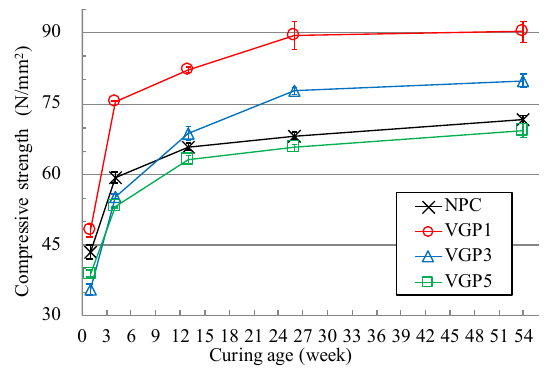
Figure 12. Compressive strength (W/B=0.2).